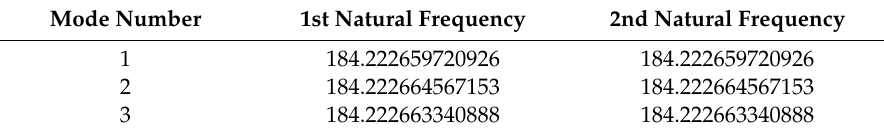
Table 3. The influence of number of modes on the natural frequencies ( Ω = 0).